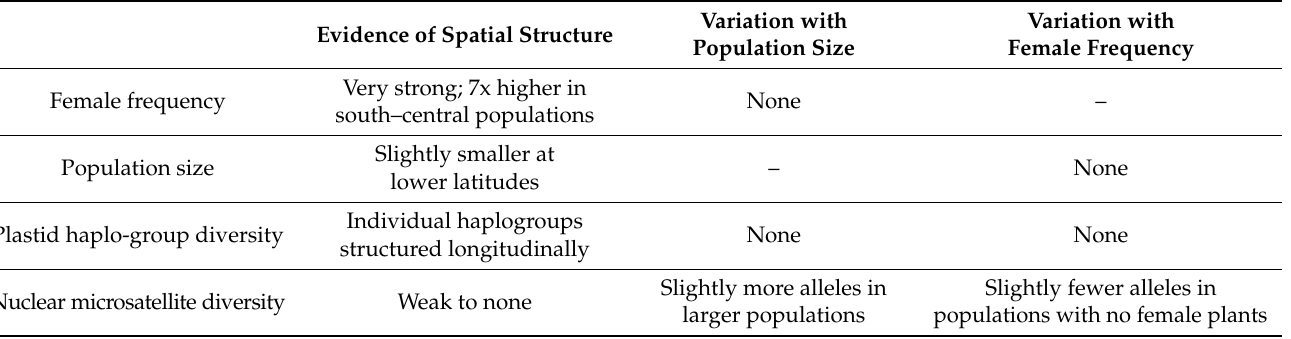
Table 2. Summary of observed associations between spatial, demographic, and genetic variables among populations of Lobelia siphilitica